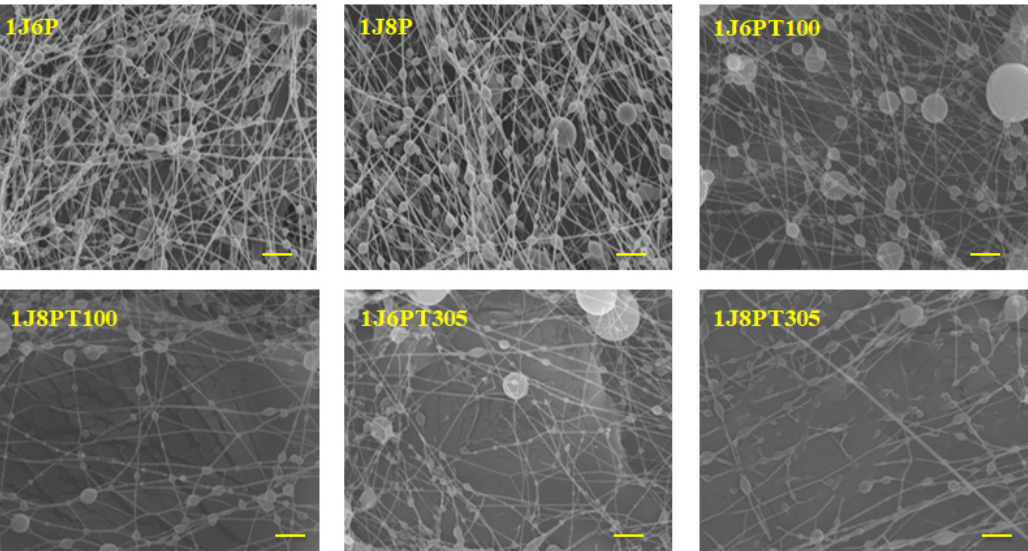
Figure 3. SEM micrographs showing the morphology and diameter distributions of 1% JFP/pullulan (6–12%) nanofibers along with surfactants (Triton X ‐ 100 and Triton X ‐ 305). Scale bar 1 μ m; 10,000×.